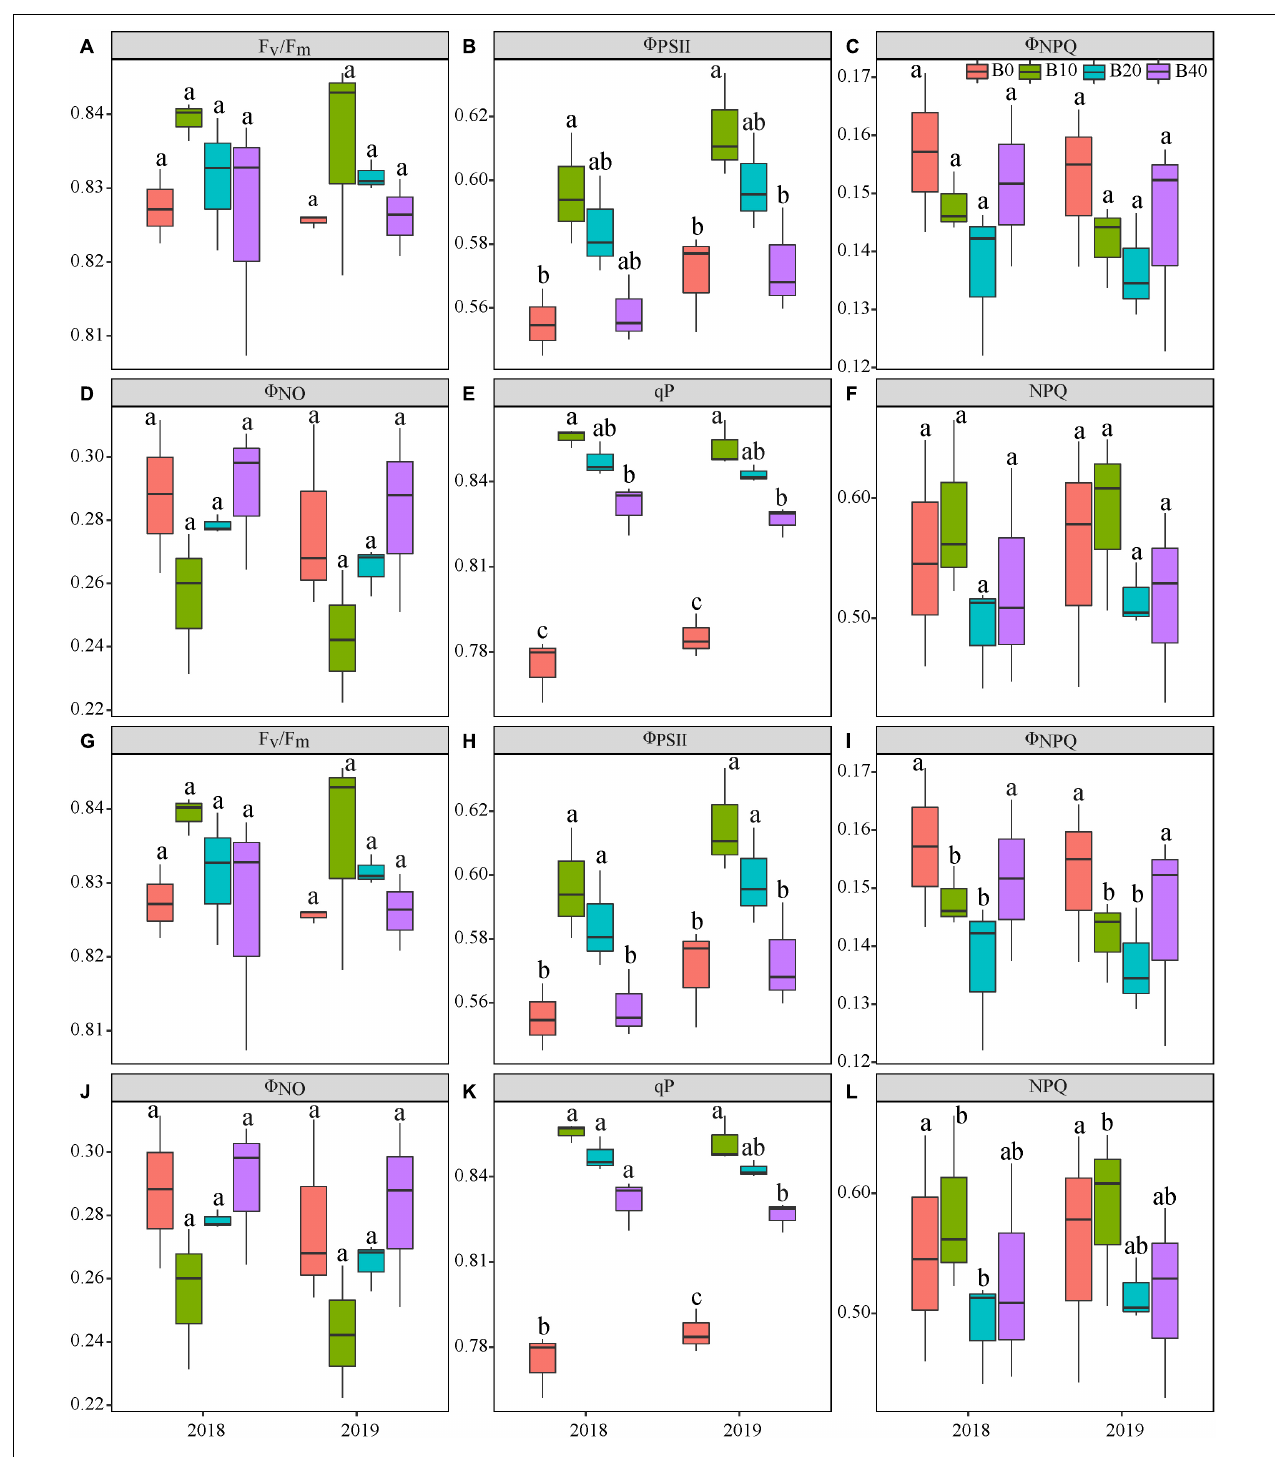
FIGURE 2 | Chlorophyll fluorescence parameters at the flowering (A–F) and pod set (G–L) in peanut with four rates of biochar in the 2018 and 2019 growing seasons. F v /F m , maximal efficiency of PSII photochemistry after dark adaptation; (cid:56) PSII , actual efficiency of PSII photochemistry after light adaptation; (cid:56) NPQ , quantum yield for energy dissipated via (cid:49) pH and xanthophyll-regulated processes; (cid:56) NO , quantum yield of non-regulated energy loss in PSII; qP, photochemical quenching; and NPQ, non-photochemical quenching. B0, B10, B20, and B40 represent biochar application rates at 0, 10, 20, and 40 t ha − 1 , respectively. For each parameter in each year, mean data with different letters denote significant difference among treatments at P < 0.05.